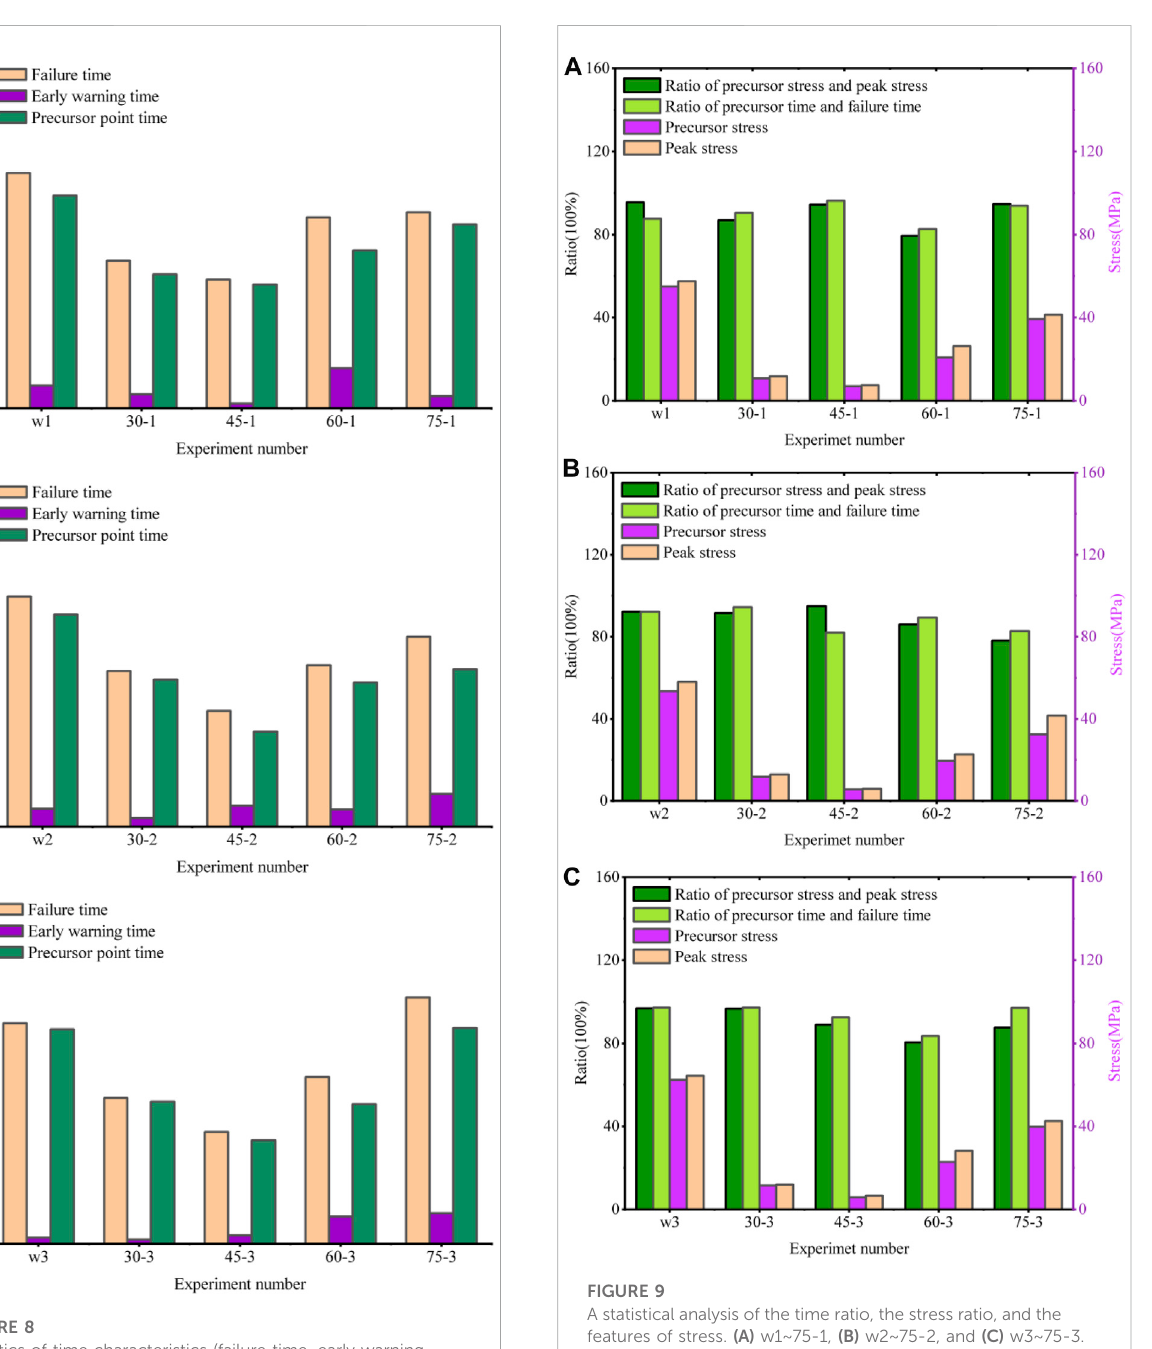
FIGURE 8 Statistics of time characteristics (failure time, early warning time, and precursor point time). (A) w1~75-1, (B) w2~75-2, and (C) w3~75-3.